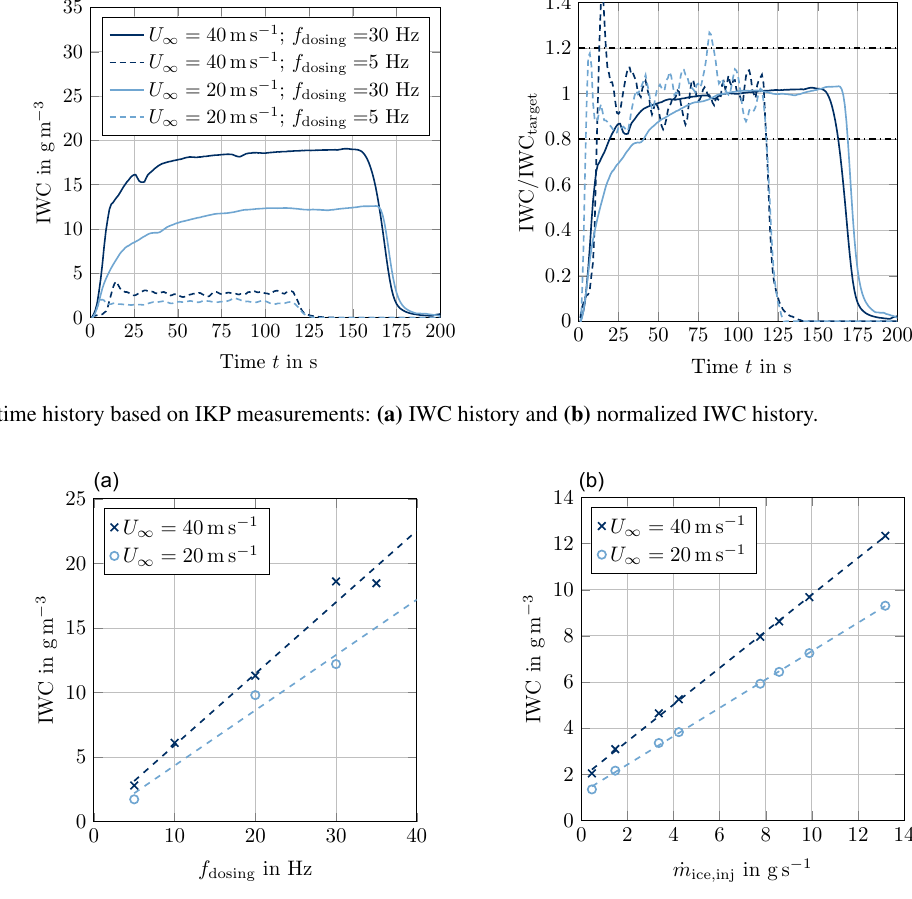
Figure 24. Ice water content depending on dosing frequency f dosing and injected ice particle flow ˙ m ice , inj